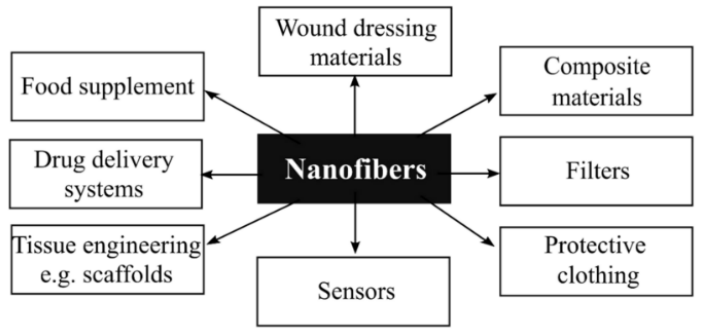
Figure 1. Applications of nanofibers in numerous aspects of daily life reproduced from [11].